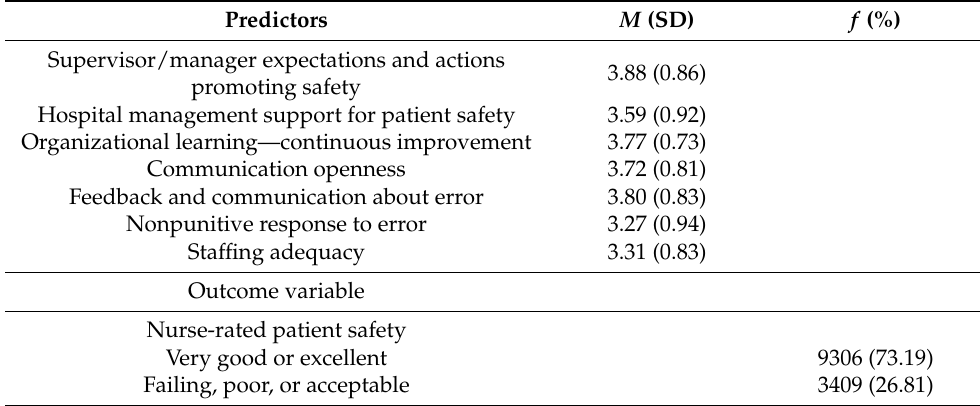
Table 2. Descriptive statistics for key predictors and outcome variable (N =